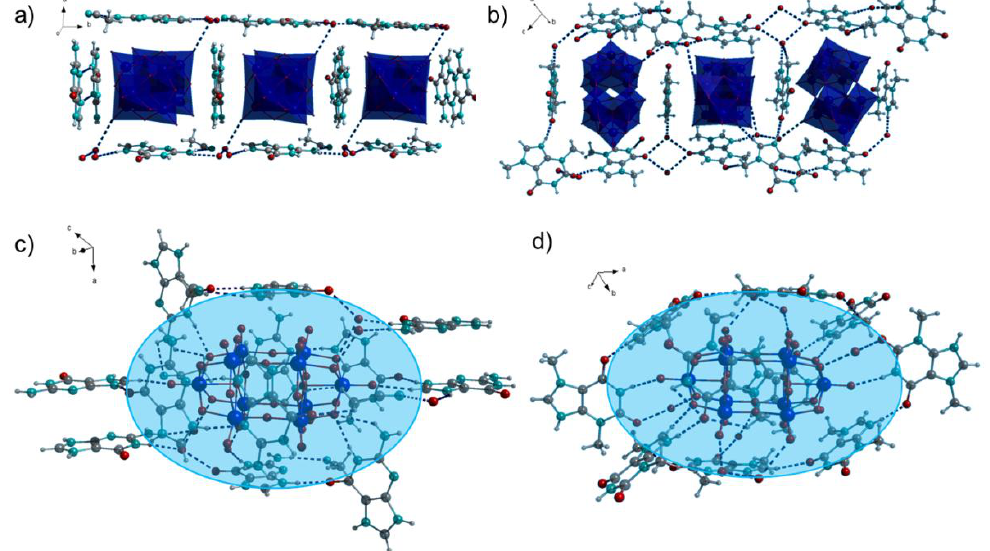
Figure 2. ( a , b ) Nanoboxes surrounding decatungstate anions in 1 and 2 ; ( c , d ) Decatungstate anions embedded into the organic matrix consisting of protonated purine bases and water molecules. Blue area indicates the organic matrix environment of the POM. W: light blue, color kept in the Figure